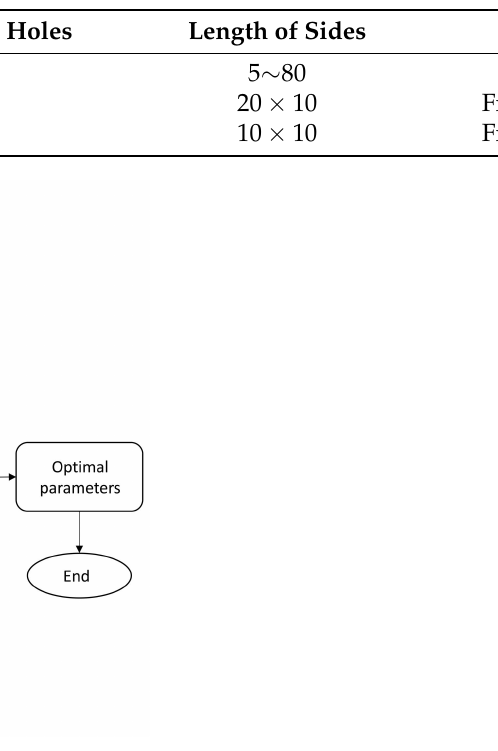
Figure 3. Schematic of the PSO